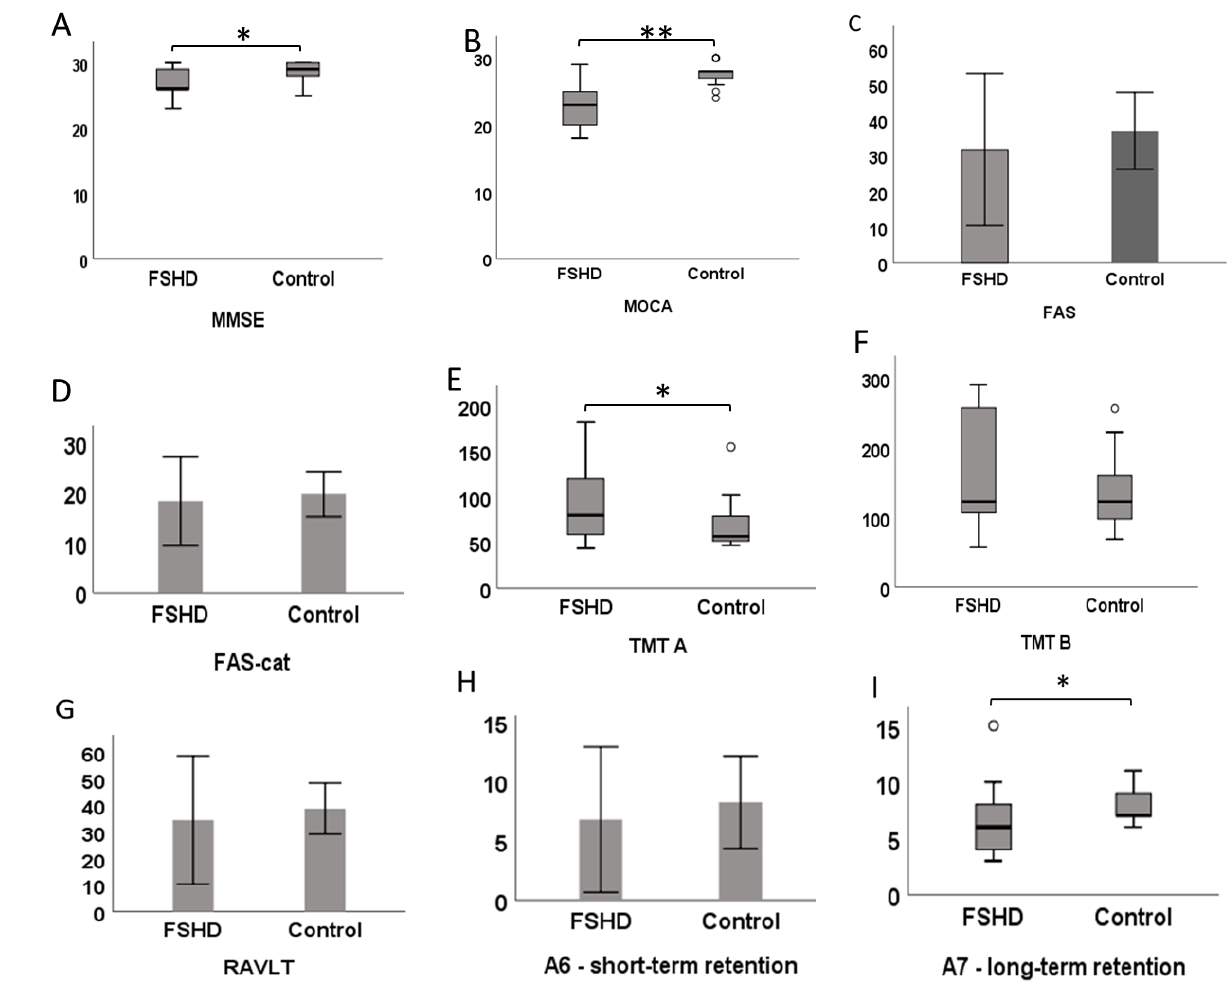
Figure 1. Comparison of cognitive test results between FSHD and control groups. Bars represent mean values and standard deviation. Box plots represent median values and interquartile ranges. *p<0.05 and **p<0.001. FSHD: facioscapulohumeral muscular dystrophy; MMSE: Mini-Mental